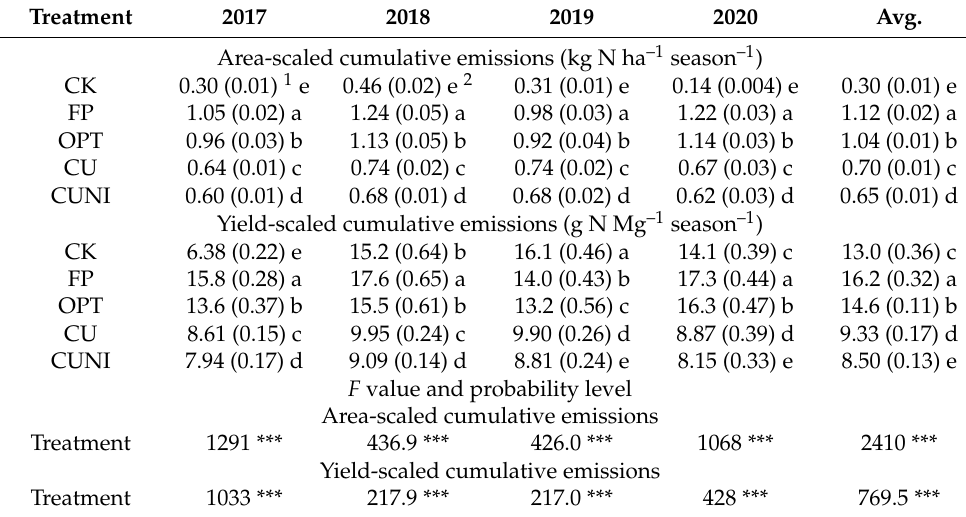
Figure 4. Daily precipitation and mean air temperature during the lettuce growing seasons in 2017 ( a ), 2018 ( b ), 2019 ( c ) and 2020 ( d ). Table 2. Area- and yield-scaled seasonal cumulative N 2 O emissions under different treatments during